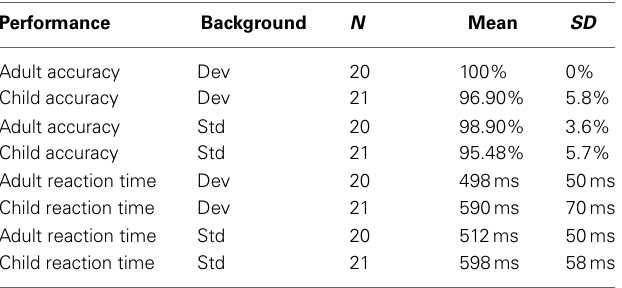
Table 1 | Behavioral data for target stimuli in adult ( N = 20) and child ( N = 21)